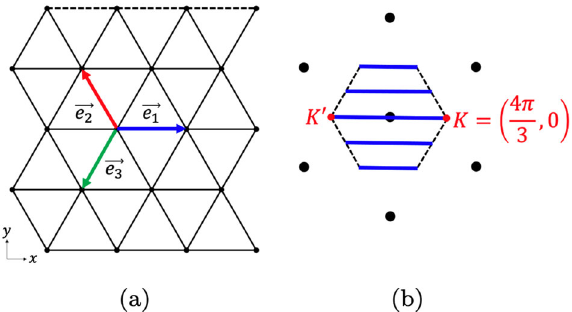
Fig. 1 Illustrations of the lattice studied. a An illustration of the four-leg triangular cylinder (identifying top row of sites with bottom row of sites). Three primitive vectors are labeled on the nearest- neighboring bonds of a site. b The corresponding fi rst BZ is contained within the black dashed lines with K , K 0 points marked. The blue bands indicate allowed values of momenta for the four-leg cylinder.